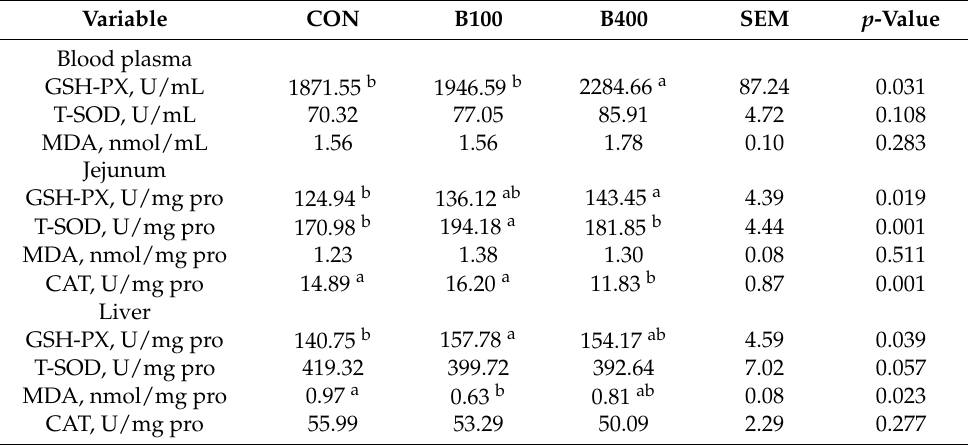
Table 5. Effects of dietary supplementation with bilberry extract on antioxidant capacity of yellow- feathered chickens at 21 d 1 .